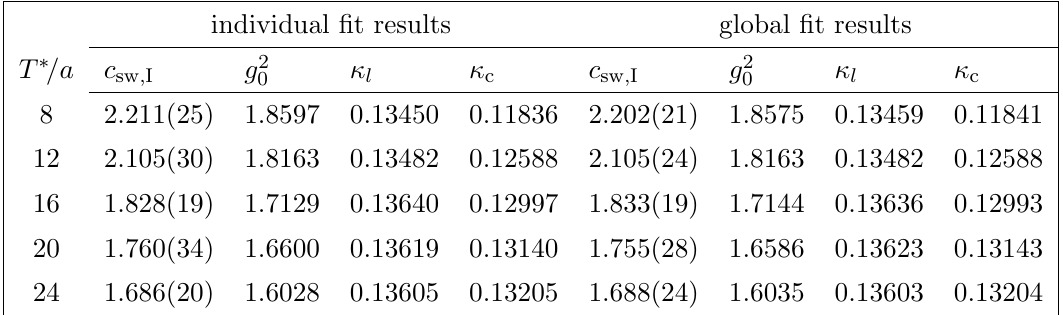
Table 3 . Interpolation results of c sw at T